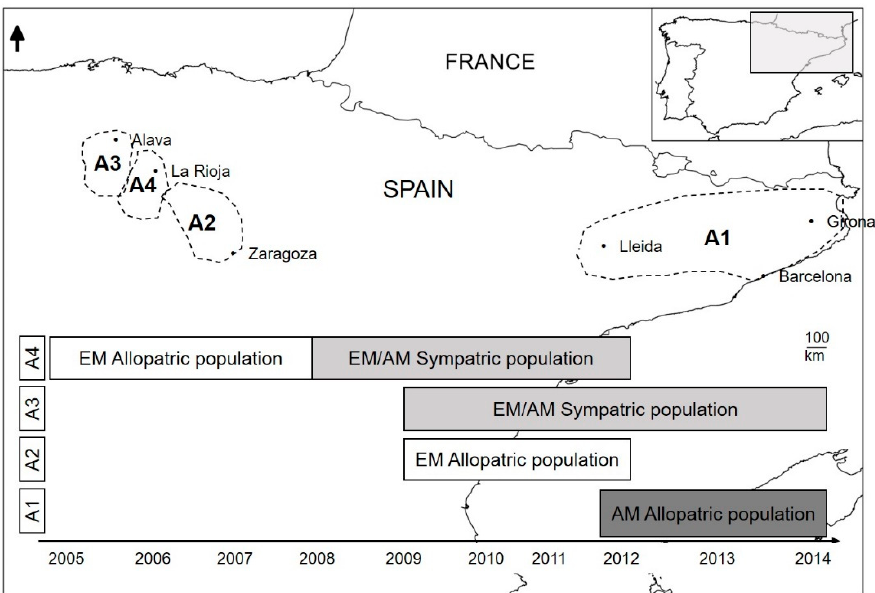
Figure 1. Study area showing the zones of sympatry between the American mink (AM) and the European mink (EM) populations in Spain. Area 1 (A1), AM allopatric populations; A2, EM allopatric populations; and A3 and A4, AM/EM sympatric populations. Diagram below shows the period during which each area was studied.